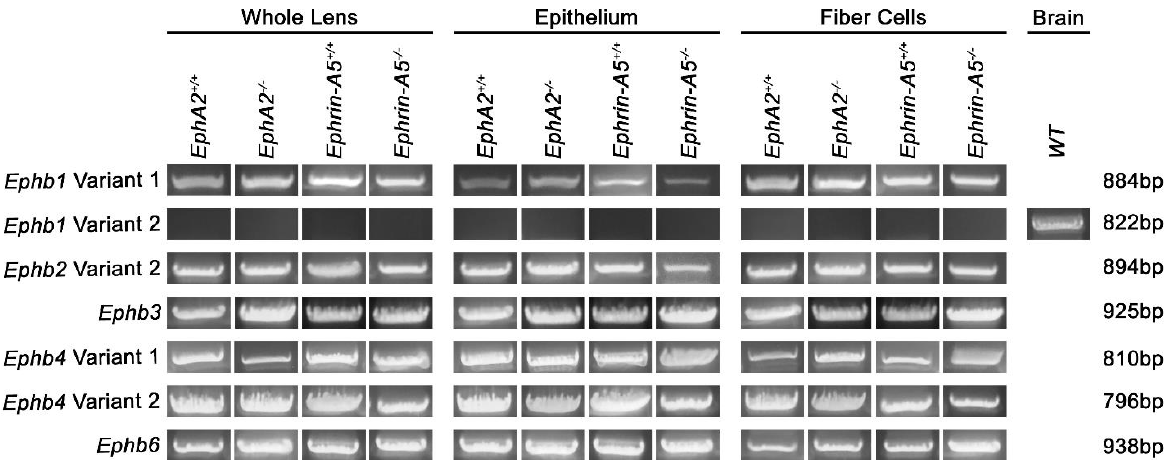
Figure 2. Ephb transcripts in whole lens, lens epithelial cell, or lens fiber cell RNA samples from 6-week-old EphA2 +/+ , EphA2 − / − , ephrin-A5 +/+ , and ephrin-A5 − / − mice. Positive control was brain RNA iso- lated from a WT control mouse. We detected Ephb1 variant 1, Ephb2 variant 2, Ephb3 , Ephb4 variants 1 and 2, and Ephb6 in the lens. We did not detect Ephb1 variant 2 in the lens.